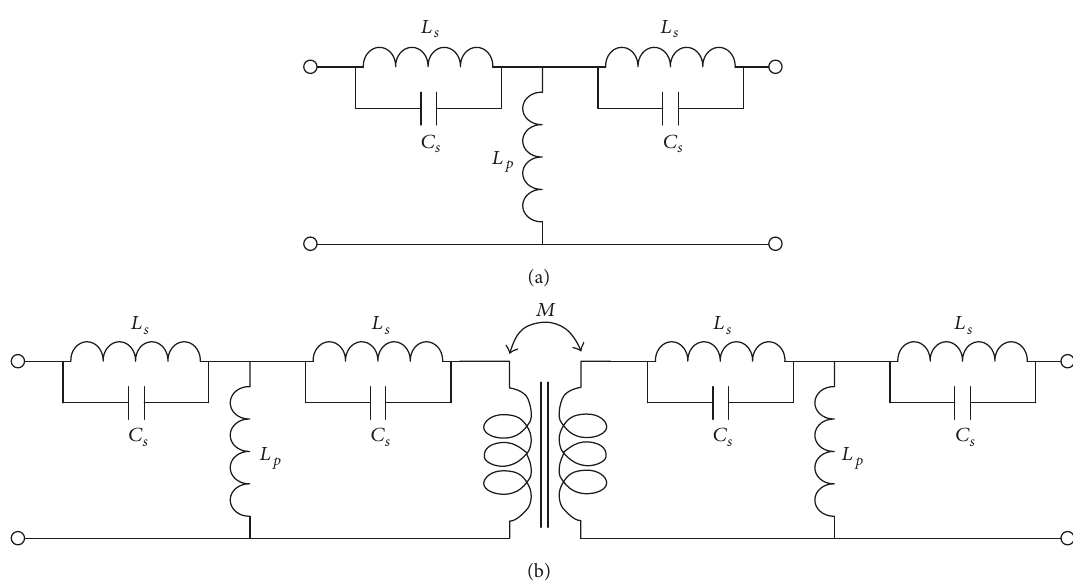
Figure 4: Equivalent circuit of (a) one-pole filter loading a SRR and (b) proposed two-pole filter loading two